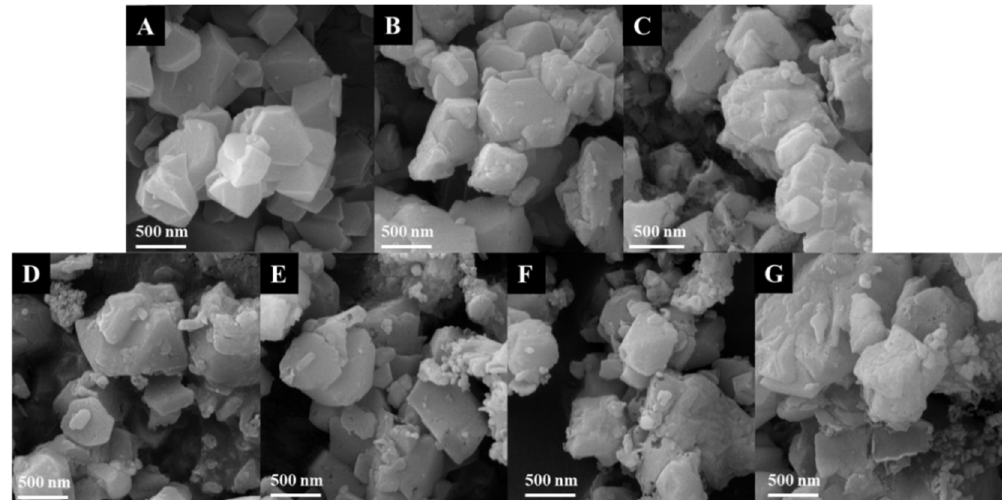
Figure 5. SEM images of ( A ) NH 4 -FAU, ( B ) La-FAU, ( C ) Fresh catalyst, ( D – G ) Spent catalyst after 15, 45, 76, and 136 min under the reaction atmosphere, respectively.